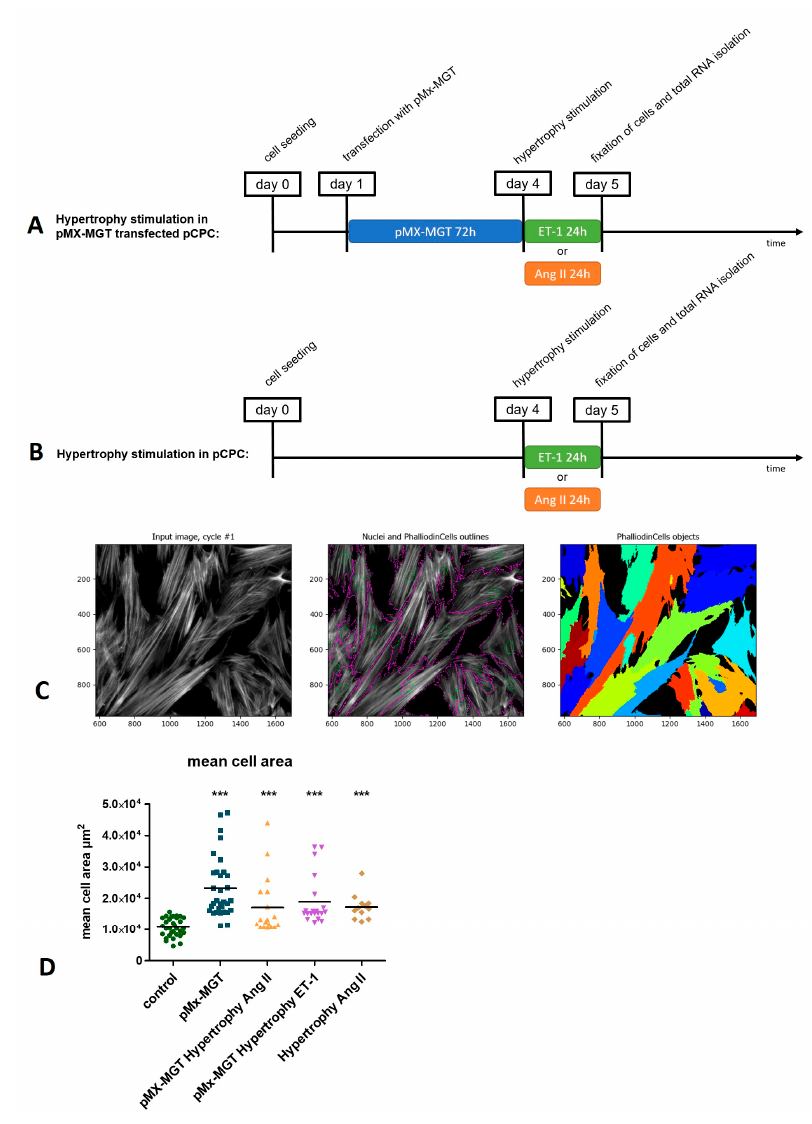
Figure 3. ( A ) Time course of hypertrophy induction of pMx-MGT -transfected Isl1 + Sca1 + ckit + pCPCs. Cells were seeded at day 0; the next day they were transfected; on day 4, hypertrophy was induced, either with ET-1 or Ang II; and on day 5, the cells were fixed, and total RNA was isolated. ( B ) Depicts the time course of the hypertrophy induction without prior transfection. ( C ) Method of mean cell area (µm 2 ) measurements using cell profiler software. Cell nuclei are marked with green, cytoplasm with purple outlines, and the mean cell area of each cell is represented in multiple colors. Mean cell area differences are depicted in ( D ).